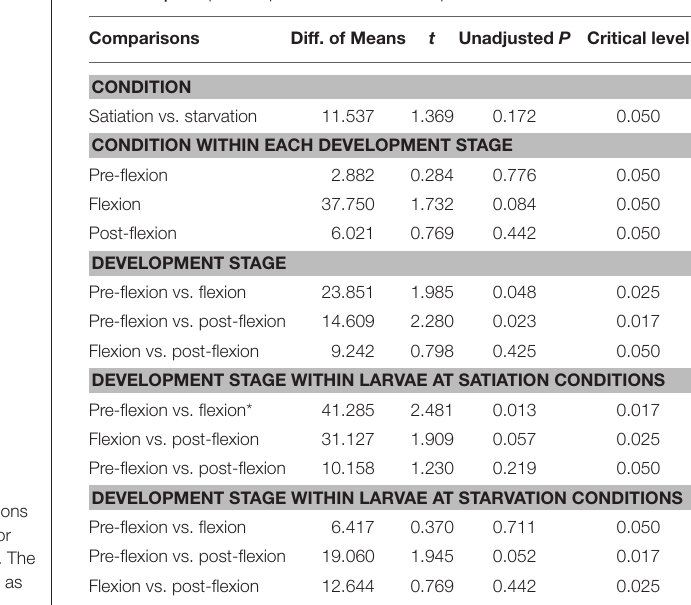
TABLE 3 | Multiple comparisons’ statistical output for the Preference